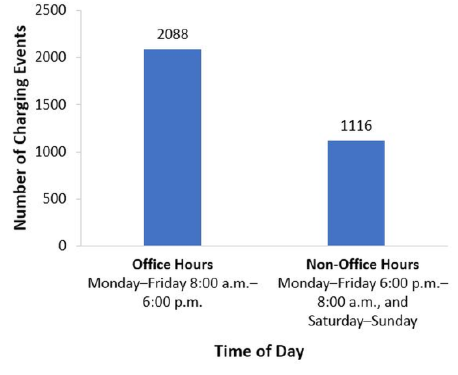
Figure 5. Office and non-office hour distribution.